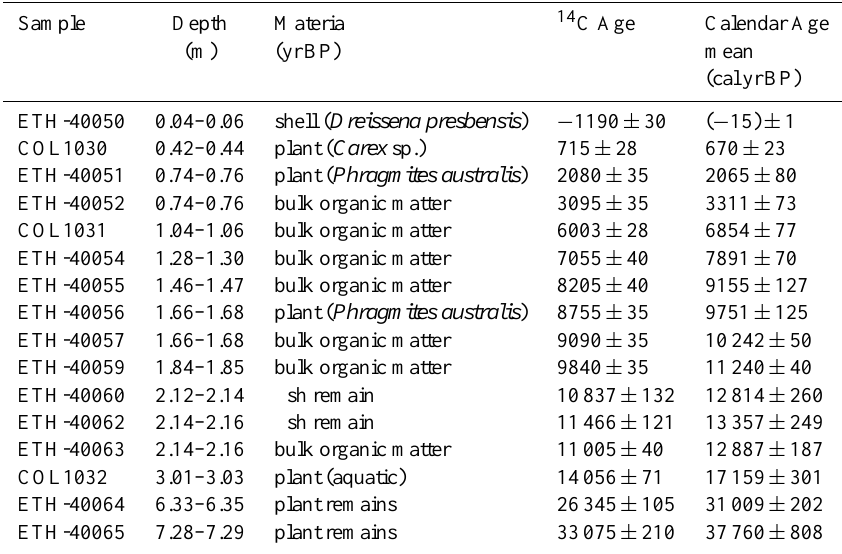
Table 1. Radiocarbon dates from core Co1215, Lake Prespa, with depth, sample number, material, radiocarbon age and calendar age for each sample (modified after Wagner et al., 2012a). The radiocarbon ages were calibrated into calendar years before present (calyrBP) with 2 σ ranges using CALIB Version 6.1.0 (Stuiver and Reimer, 2011). The uppermost sample (ETH-40050) from 0.04–0.06m depth was calibrated using CALIBomb (Reimer et al., 2004) with the Levin.14c dataset (Levin and Kromer, 2004). Sample Depth Materia 14 C Age Calendar Age (m) (yrBP) mean (calyrBP) ETH-40050 0.04–0.06 shell ( Dreissena presbensis ) − 1190 ± 30 ( − 15) ± 1 COL1030 0.42–0.44 plant ( Carex